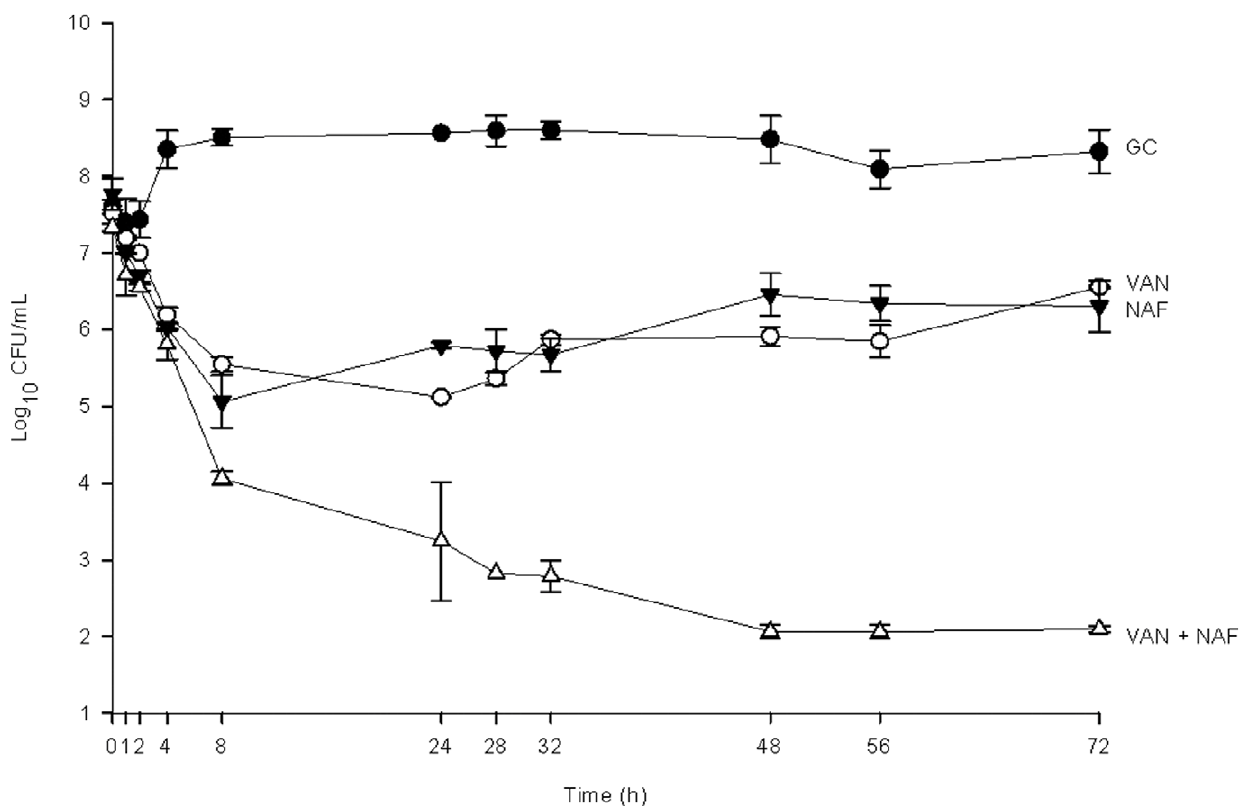
Figure 3. Activity of vancomycin and nafcillin alone and in combination in the PK/PD model against the hVISA strain with a nafcillin MIC of 4 m g/mL (R1629). Data are presented as a graph of the mean bacteria remaining vs. time with error bars at the sampling points representing 1 standard deviation from the mean. GC=Growth Control, NAF=Nafcillin, VAN=Vancomycin.